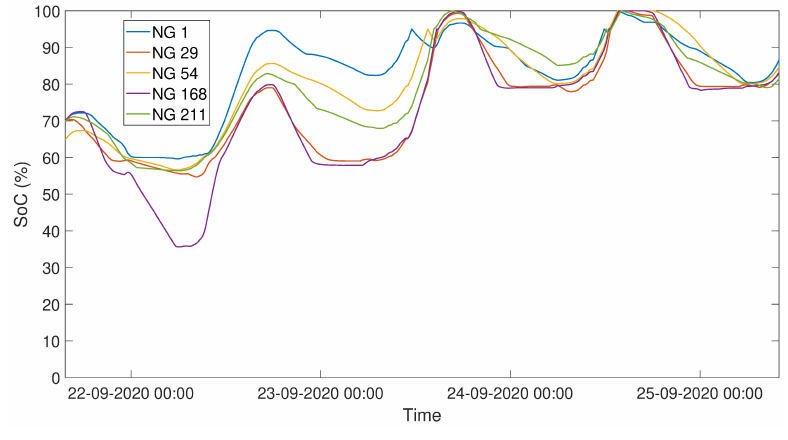
Figure 11. Evolution of the SoC of the NGs—microgrid connection